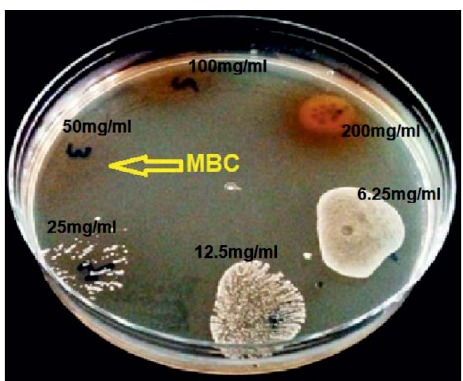
Fig. 3. Representative photo showing determination of MBC value (white spots are the bacterial